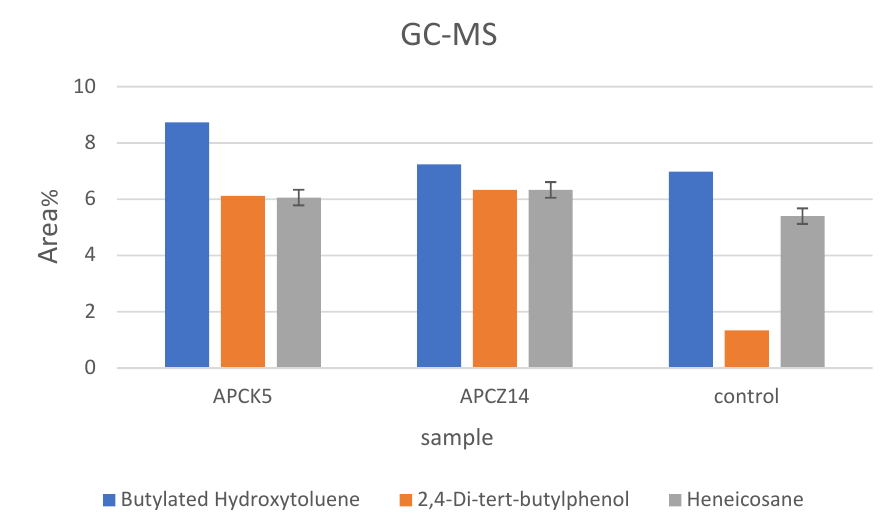
Figure 6. GC–MS for the highest compounds; heneicosane, 2,4-di-tert-butylphenol, and butylated hydroxytoluene after 180-day incubation with APCK5, APCZ14, and control.